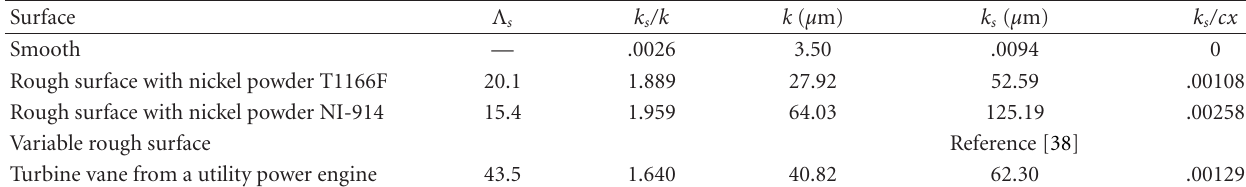
Table 2: Characteristics of rough surfaces employed for the cambered turbine vane investigations [38]. Surface Λ s k s /k k ( μ m) k s ( μ m) k s /cx Smooth — .0026 Rough surface with nickel powder T1166F 20.1 Rough surface with nickel powder NI-914 Variable rough surface Turbine vane from a utility power